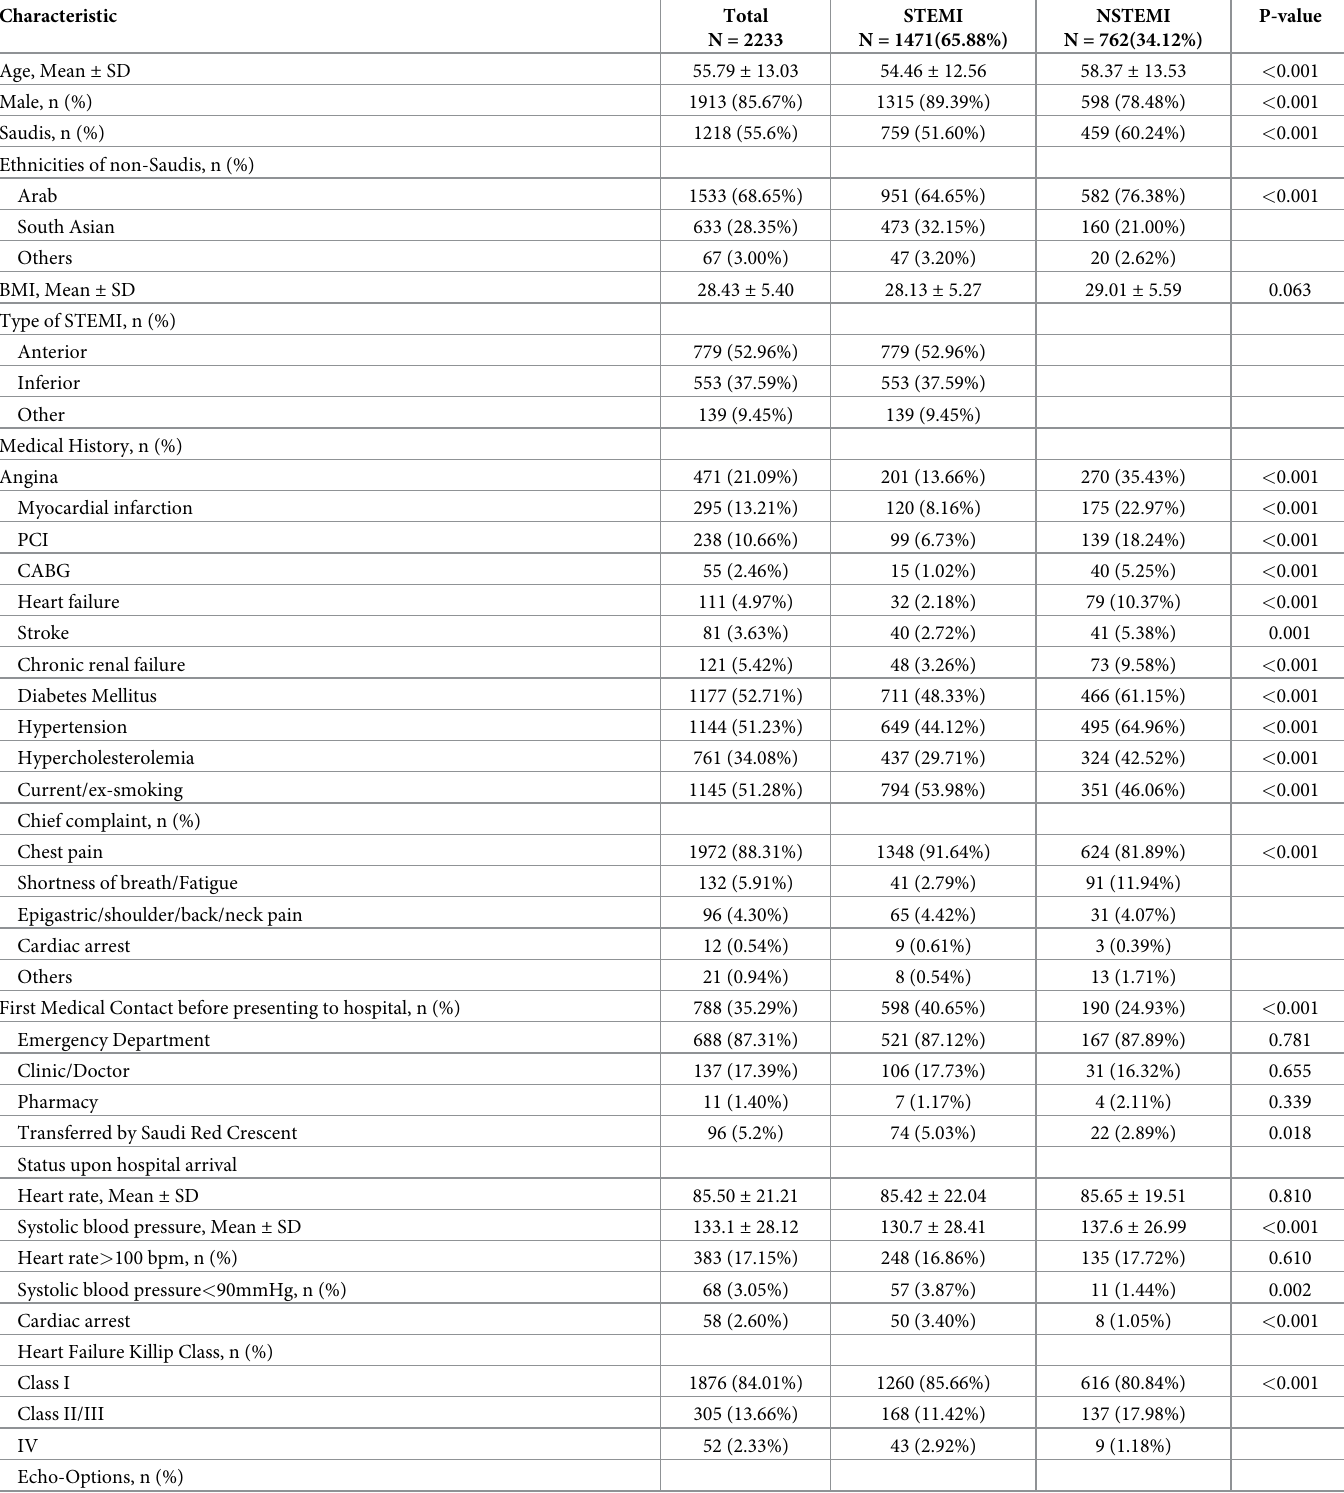
Table 1. Baseline characteristics, clinical presentation, and cardiac procedures in patients with acute Myocardial